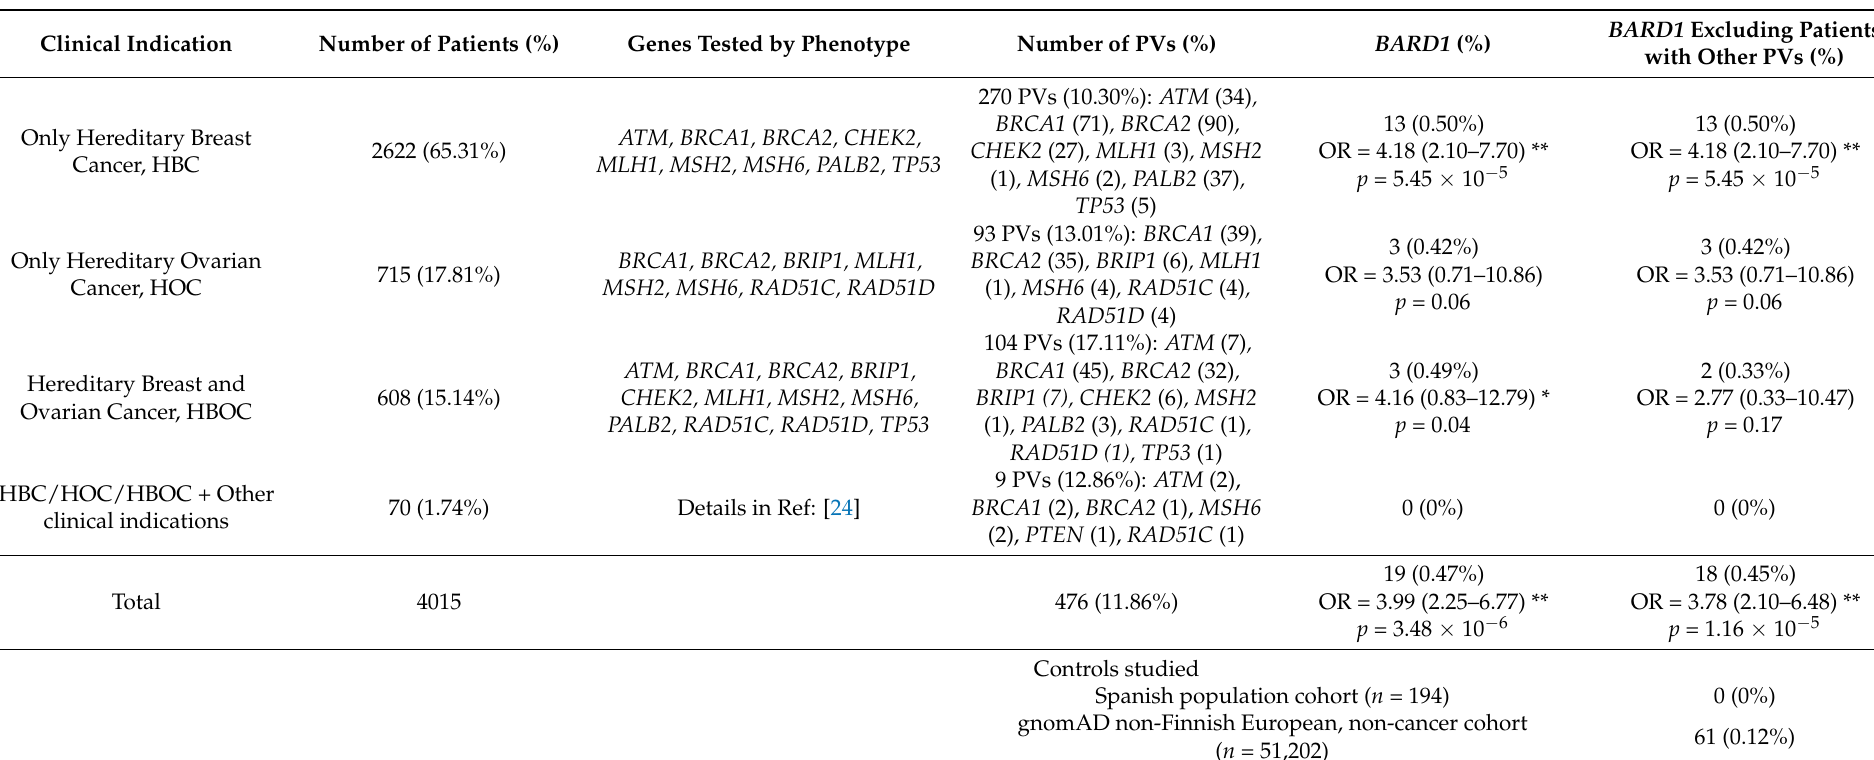
Table 1. Summary of the next-generation sequencing (NGS) panel results in our hereditary breast and/or ovarian cancer (HBOC) cohort and in the control populations.